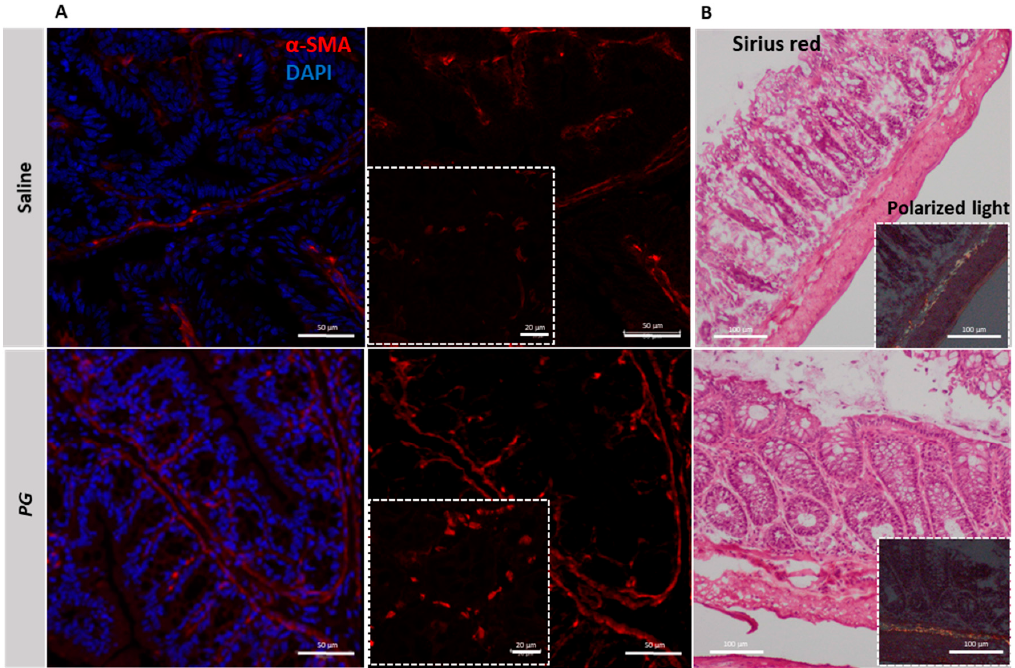
Figure 5. PG -activated fibroblasts during the recovery phase of acute colitis. ( A ) Representative immunofluorescence staining of α -SMA (red) in the colonic section of colitic mice in resolution phase treated with saline or PG . DAPI = nuclei in blue. Scale bar = 50 μ m; Scale bar magnification = 20 μ m. ( B ) Sirius red staining and polarized light microscopy showing the collagen deposition and the dif- ferent collagen fibers (green, yellow, and red), respectively, in the colonic mucosa of colitic mice during the resolution phase subjected to saline or PG treatment. n = 3 mice/group. Scale bar = 100 μ m.